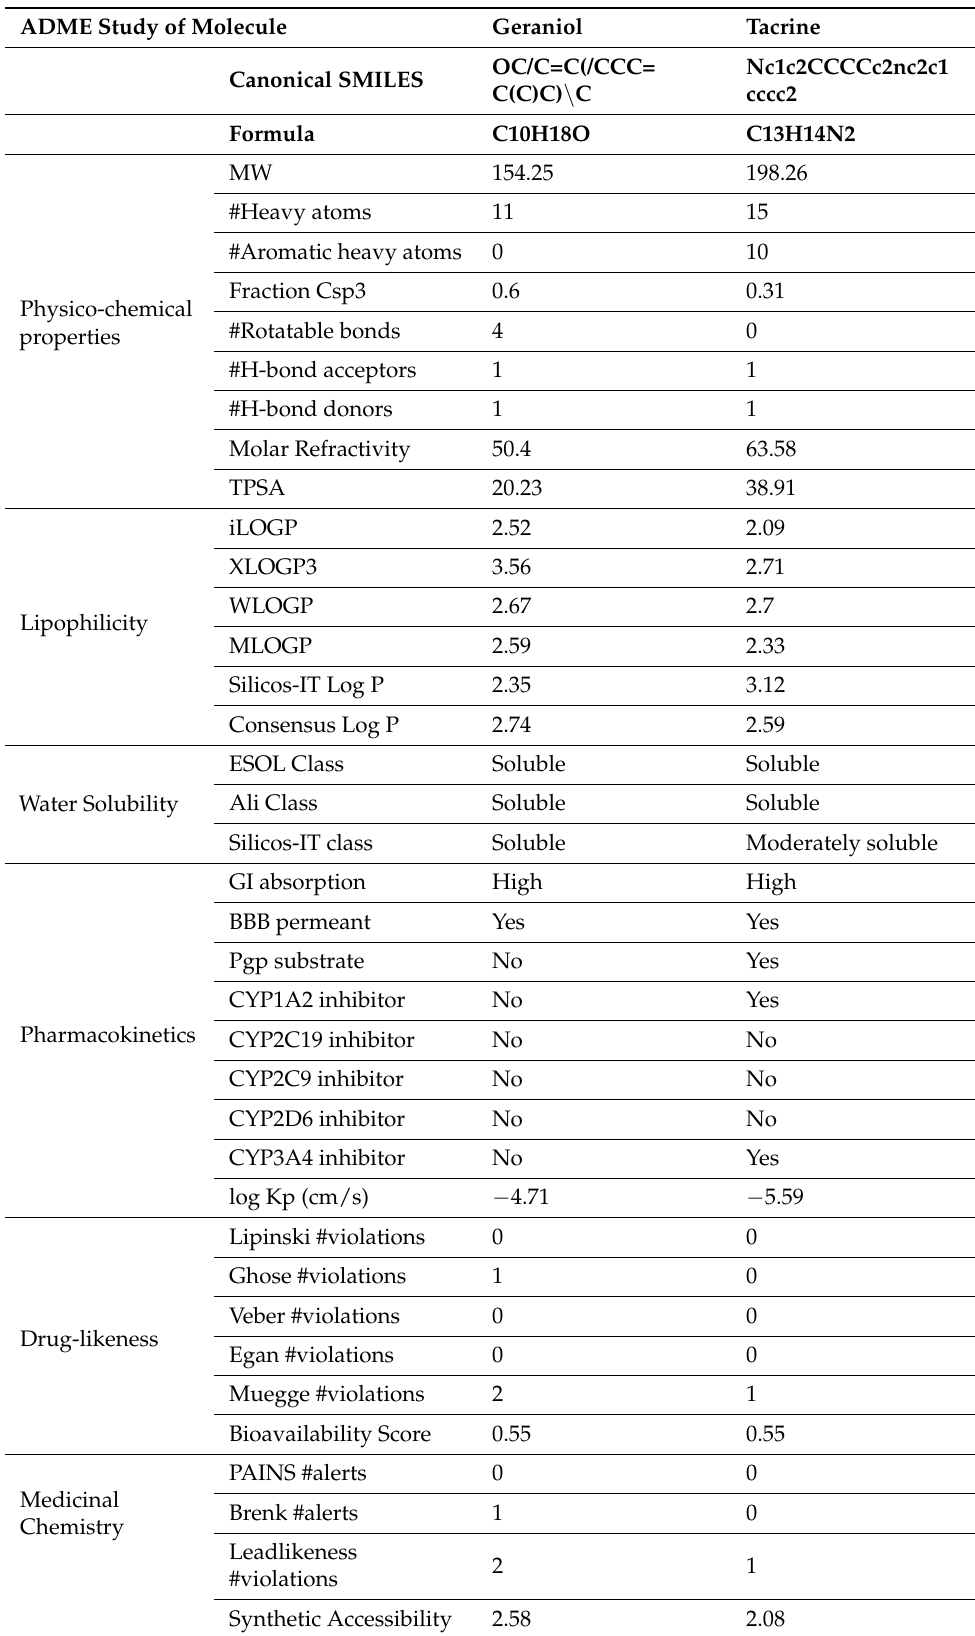
Table 1. SwissADME analysis report for geraniol and